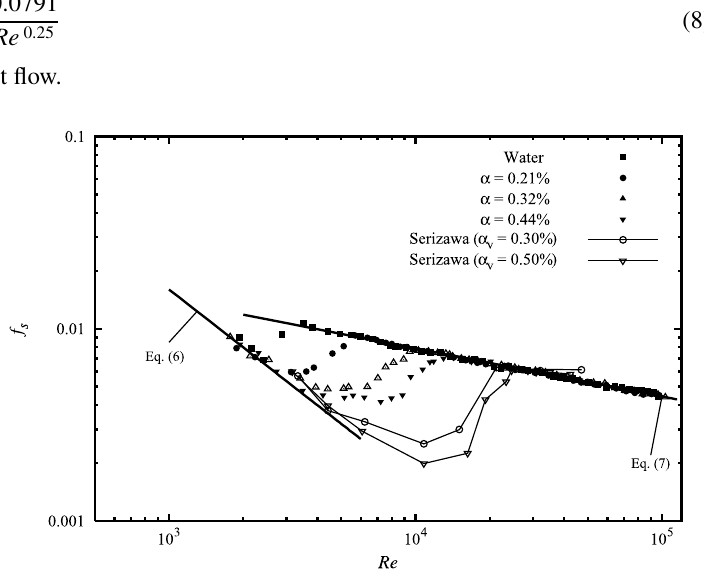
Fig. 7 E ff ect of air fraction on friction factor for straight